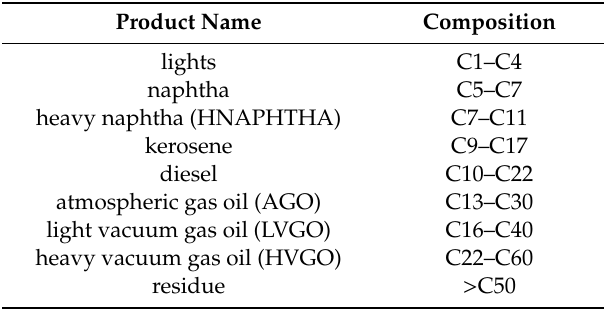
Table 1. The composition of products of this example.